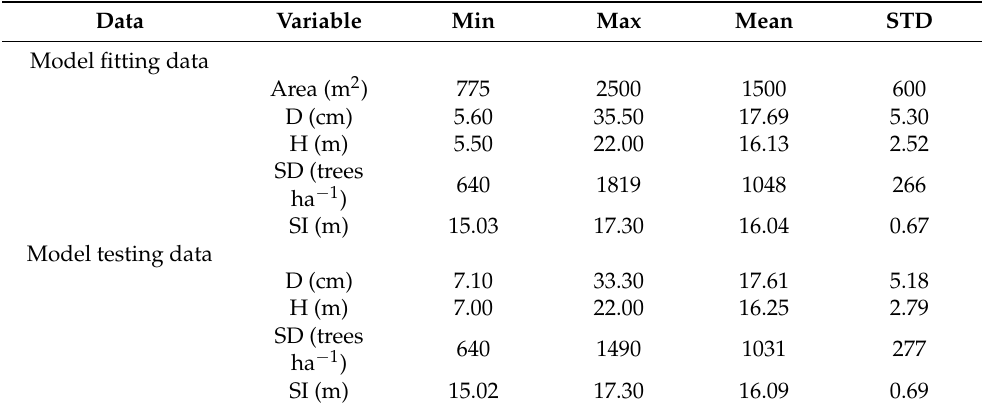
Table 2. Summary statistics of stand variables from sample plots used for model fitting and